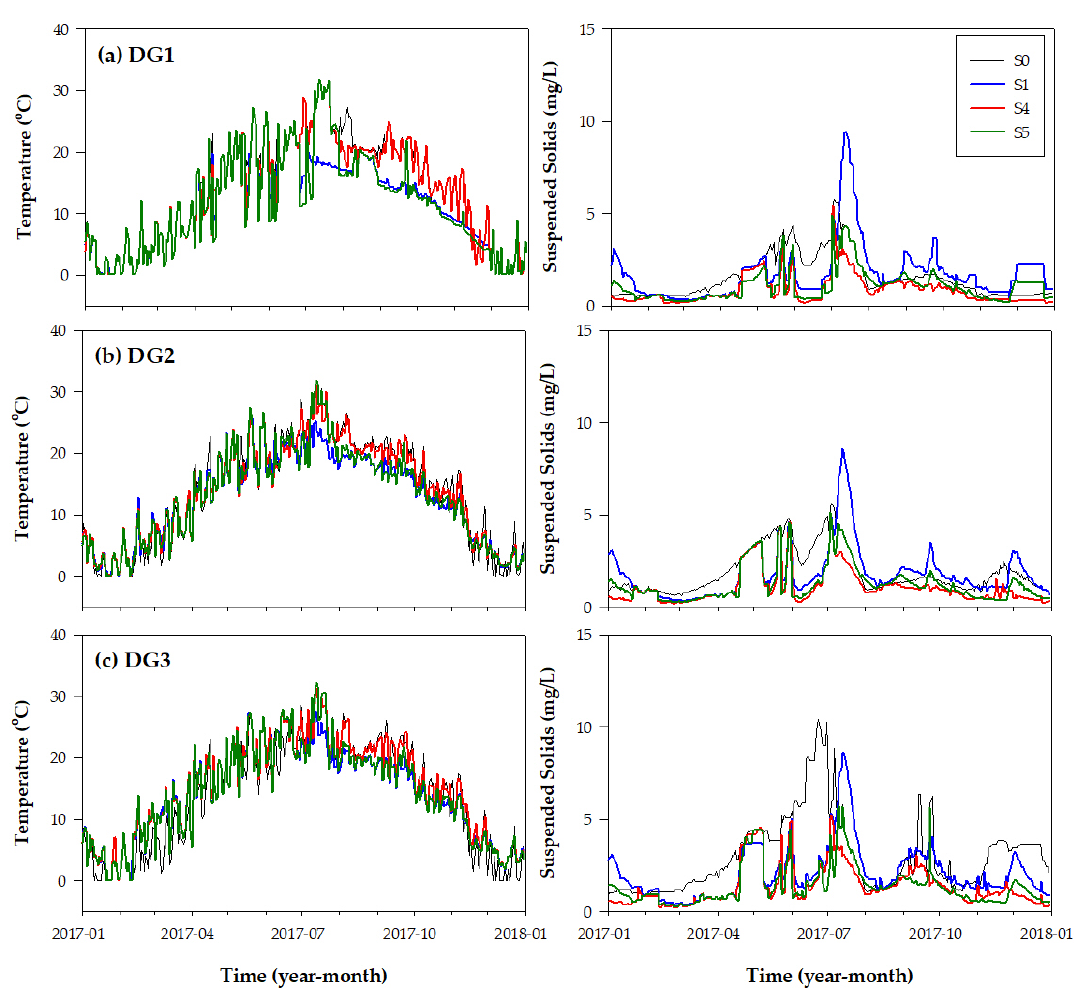
Figure 7. Comparison of the temperature and SS concentration with the selective withdrawal in Doam Lake according to the installation of constructed wetlands in Kangnung Namdae Stream at ( a ) DG1, ( b ) DG2, and ( c ) DG3.